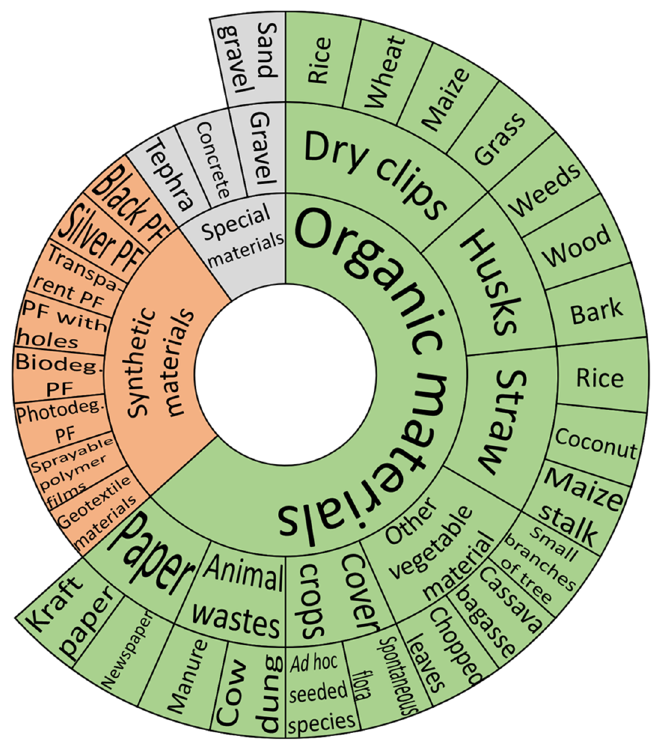
Figure 5. Mulches divided into classes of materials. Modified and adapted from Kader et al. [28]. PF: plastic film.